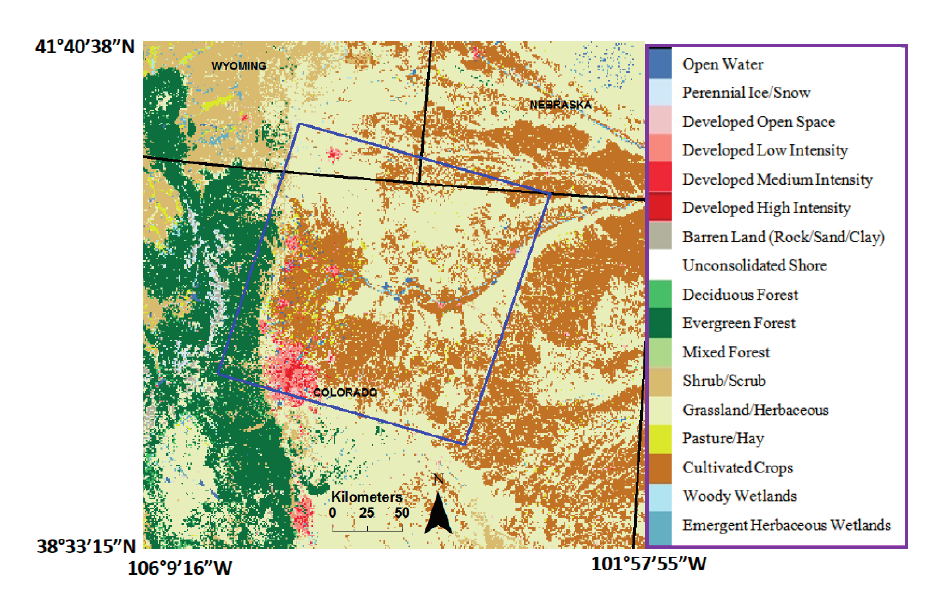
Figure 1. Location of the study area (inside the blue outline) and the land cover types as identified in the National Land Cover Database (NLCD)